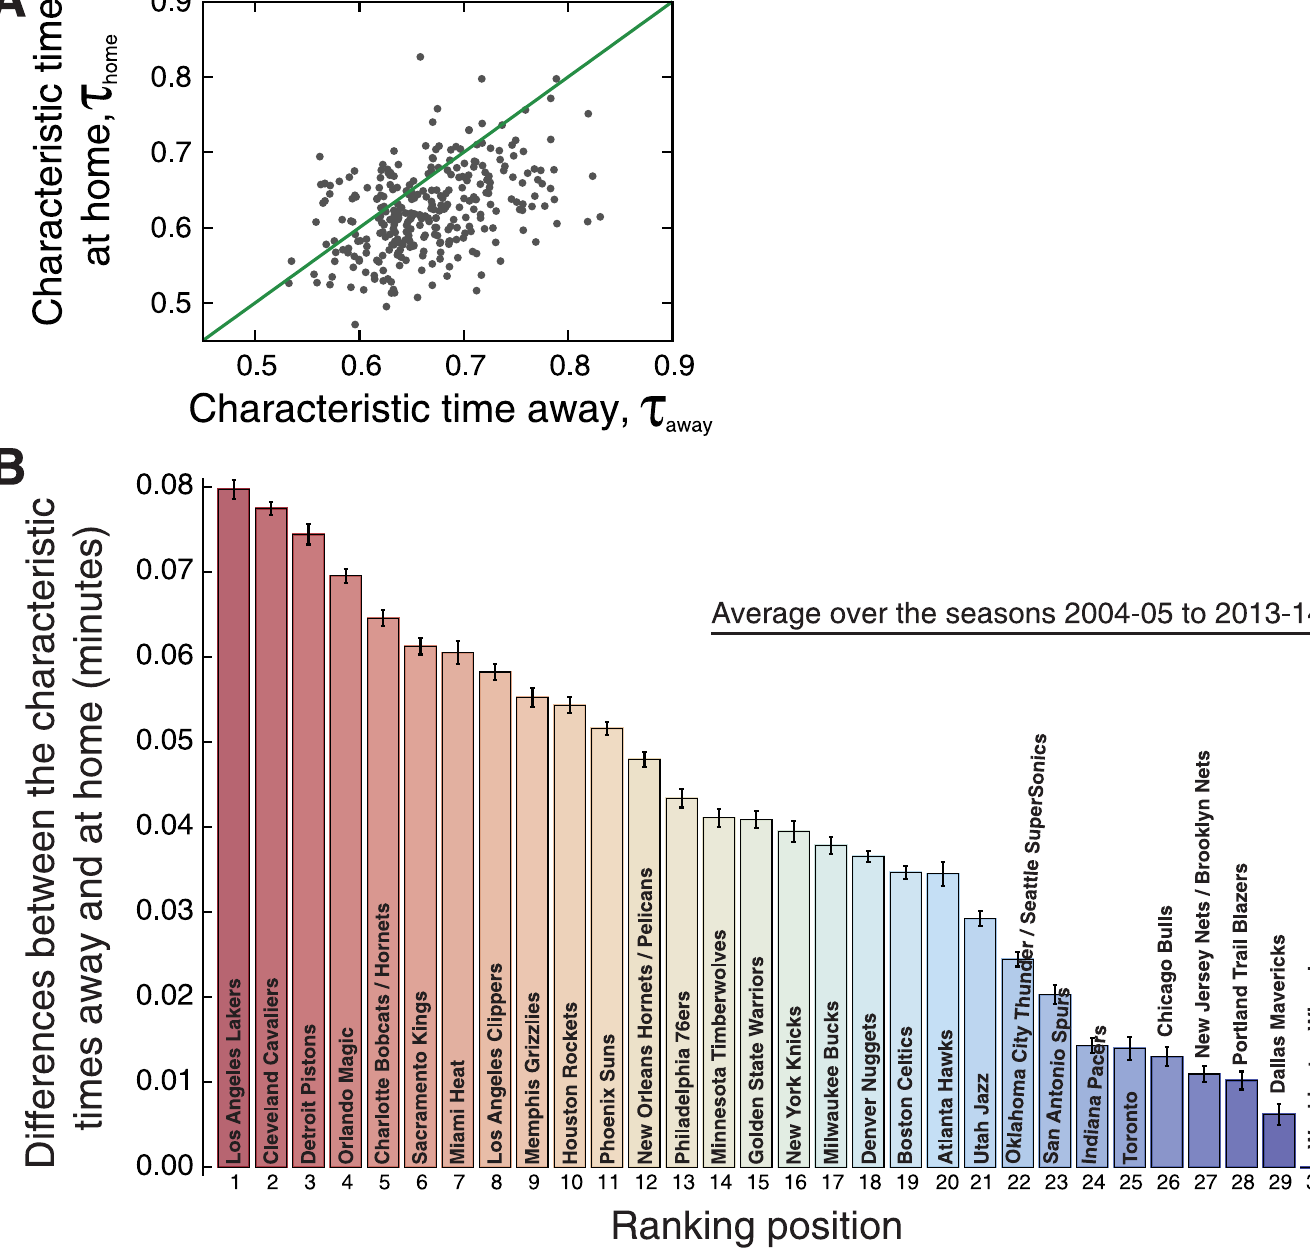
Fig 7. Ranking NBA teams according to the difference between the characteristic time intervals at home and away. (A) Characteristic time intervals between scores at home ( τ home ) versus away ( τ away ). The dots represent the values of the characteristic times (at home and away) for every team and season from 2004 – 05 to 2013 – 14 (during this period the teams were the same), and the green line is a linear function ( τ home = τ away ). Here we have aggregated data from all quarters and estimated the characteristic times via maximum likelihood method. Notice that there are only a few cases in which the characteristic time is larger when playing home than when playing away. (B) Average of the difference between τ away and τ home for each NBA team (in descending order). These averages were calculated over the seasons 2004 – 05 to 2013 – 14 (see S7 Fig for the cumulative distributions) and the error bars are 95% bootstrap confidence